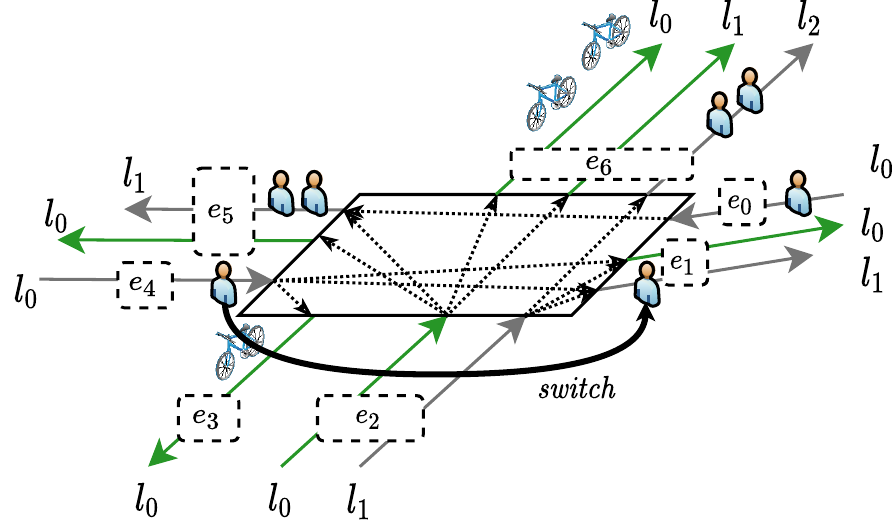
Figure 5. Schematic diagram of an MSP (parallelogram). Each incoming or outgoing edge e i represents a traffic road that can consist of one or more modality-specific traffic lanes l j . Gray lanes indicate pedestrian lanes (i.e., Walking) and green lanes indicate cycling paths (i.e., Own Bike or Shared Bike). Driving lanes are not shown. The dotted lines inside the MSP indicate lane switches—and possible implied modality switches—that can occur when an agent passes through. The curved solid black arrow indicates an agent crossing the MSP via a mapping from e 4 to e 1 , in this case without changing its